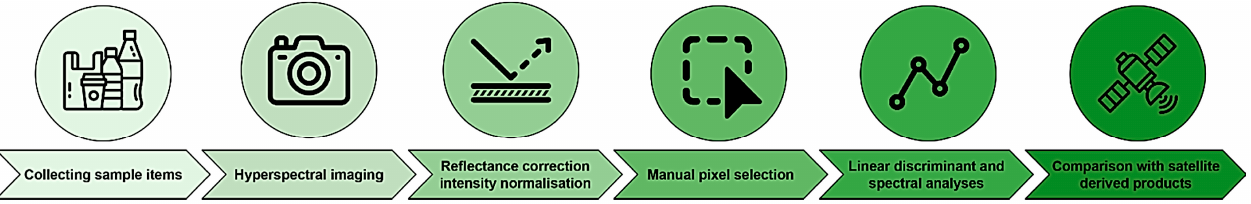
Figure 1. Flowchart of the materials and methods applied in this study, divided into six main